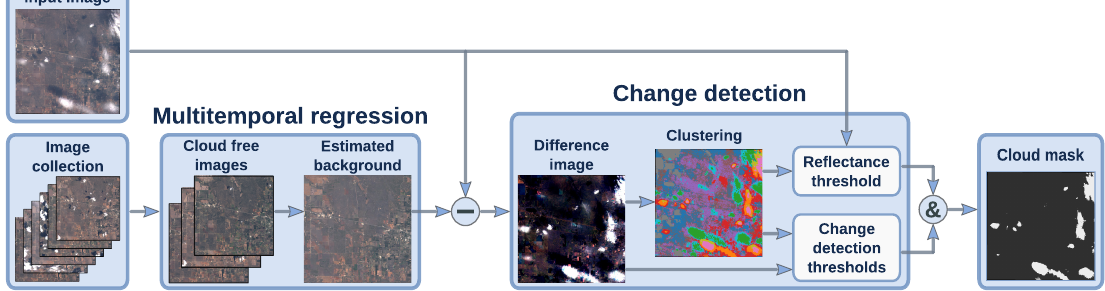
Figure 2. Multitemporal cloud detection scheme implemented on the Google Earth Engine